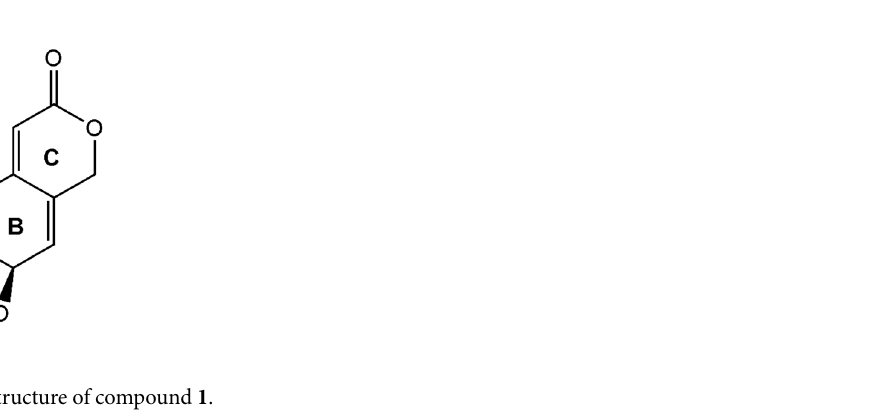
Table 2. NMR (400 MHz) spectral data of compound 1 recorded in CDCl 3 . a Overlapping chemical shifts.